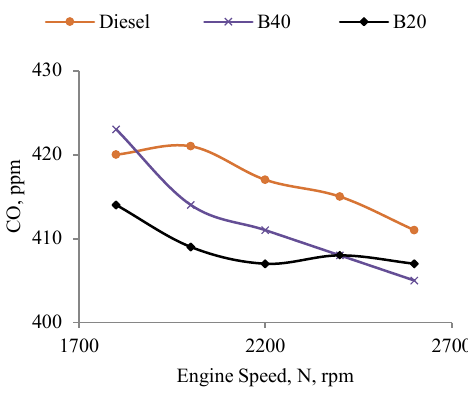
Fig. 10. CO emission in diesel engine for diesel and biodiesel